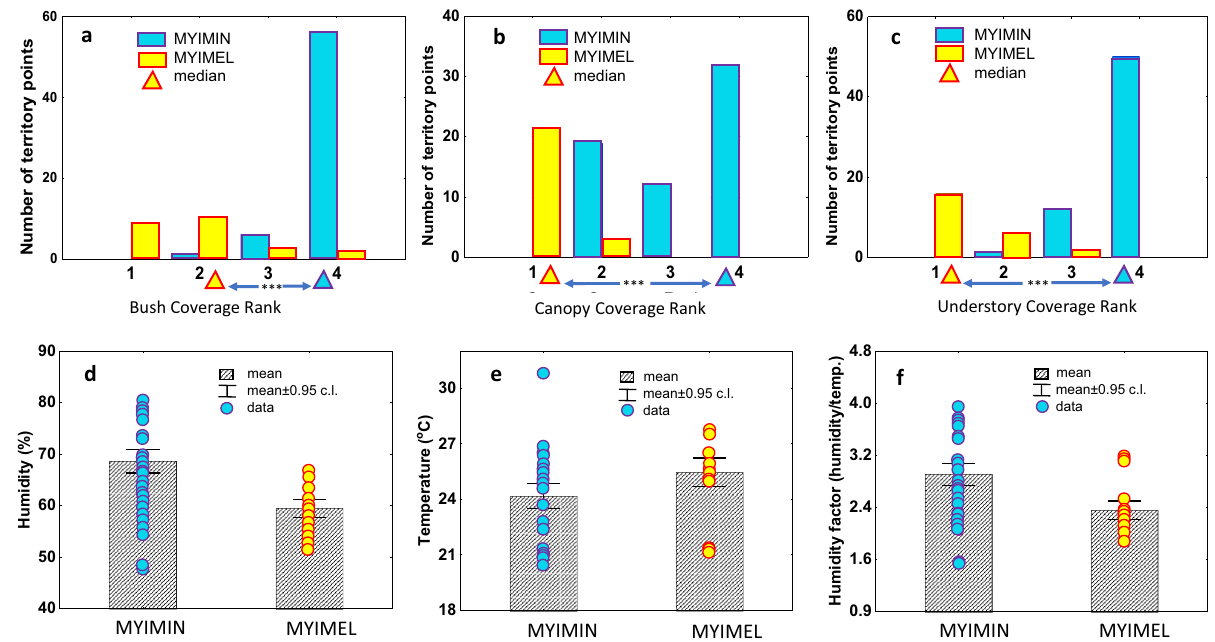
Figure 3. Characteristics of territories of Myioborus miniatus (MYIMIN; blue filled, violet edges) and Myioborus melanocephalus (MYIMEL; yellow shading, red edges) at the study site. Comparison of distributions of bush coverage rank ( a ), canopy coverage rank ( b ) and understory coverage rank ( c ), and comparison of humidity ( d ), temperature ( e ) and humidity factor ( f ) between the two species. Based on n = 63 and n = 24 points measured in the territories of M. miniatus and M. melanocephalus , respectively. Summary statistics for variables in ( a – c ) are presented in Supplementary Table S2, and for variables in ( d – f ) are presented in Supplementary Table